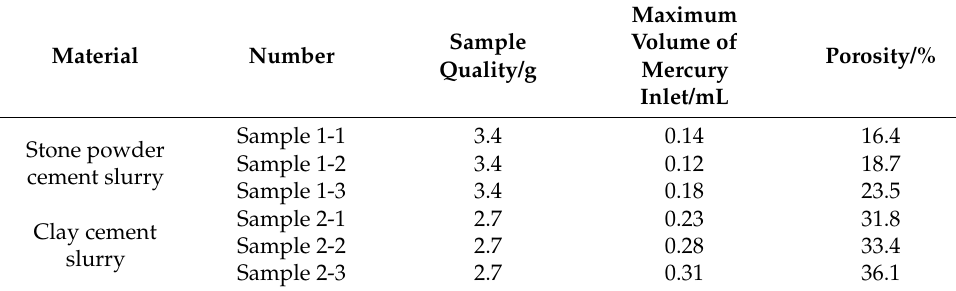
Table 9. Mercury intrusion test parameters.